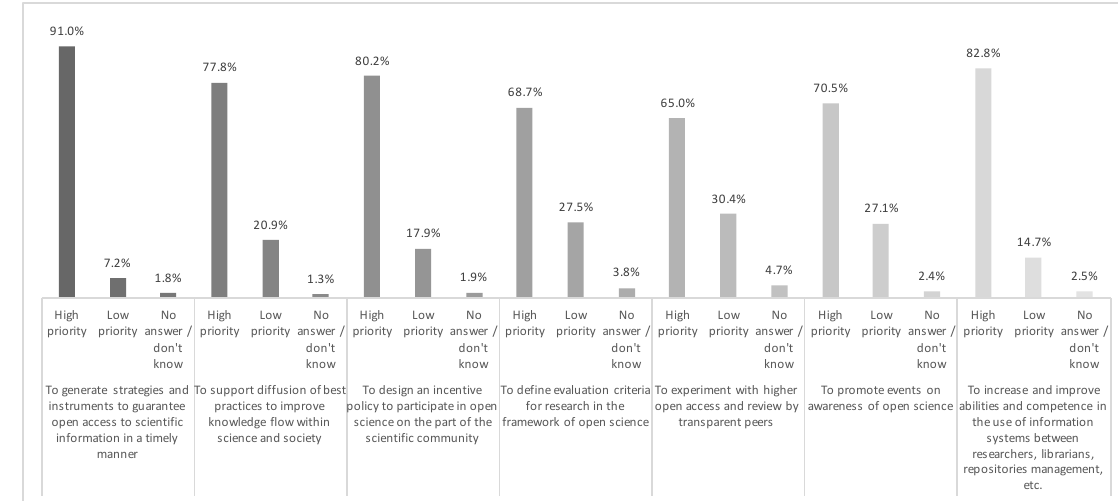
Figure A6. Main priorities for an open science policy, according to Colombian researchers.